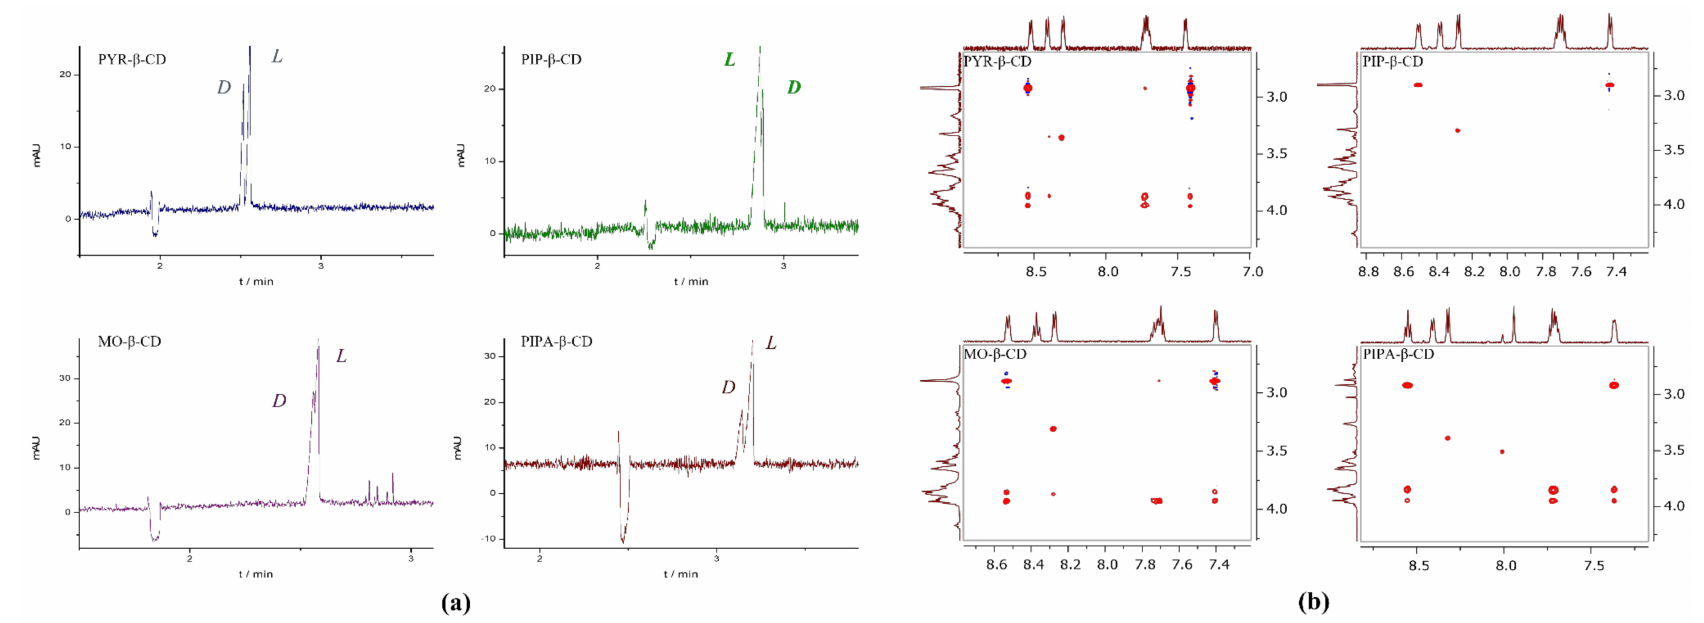
Figure 3. ( a ) Substitution-dependent EMO reversal applying 2.5 mM PYR- β -CD, PIP- β -CD MO- β -CD or PIPA- β -CD at pH 6.0 (48.5/40 cm, 50 µ m id capillary, 20 mM NaH 2 PO 4 -NaOH pH 6.0 BGE, 25 kV; 25 ◦ C; 200 nm.) ( b ) Partial 2D ROESY spectra of Dns-Val and 6- N -heterocycle- β -CDs showing the section of the feasible interactions between the aromatic region of Dns-Val and the